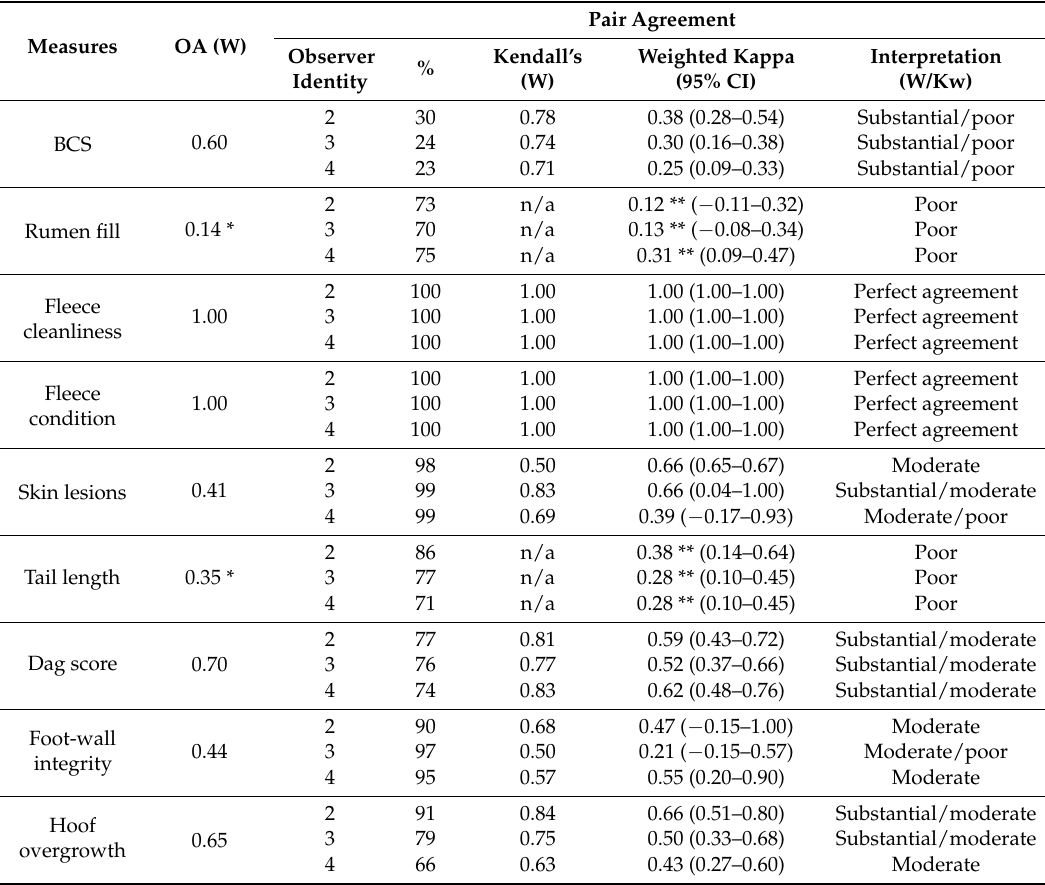
Table 2. Overall observer agreement (OA), percentage of agreement (%) and pair agreement at